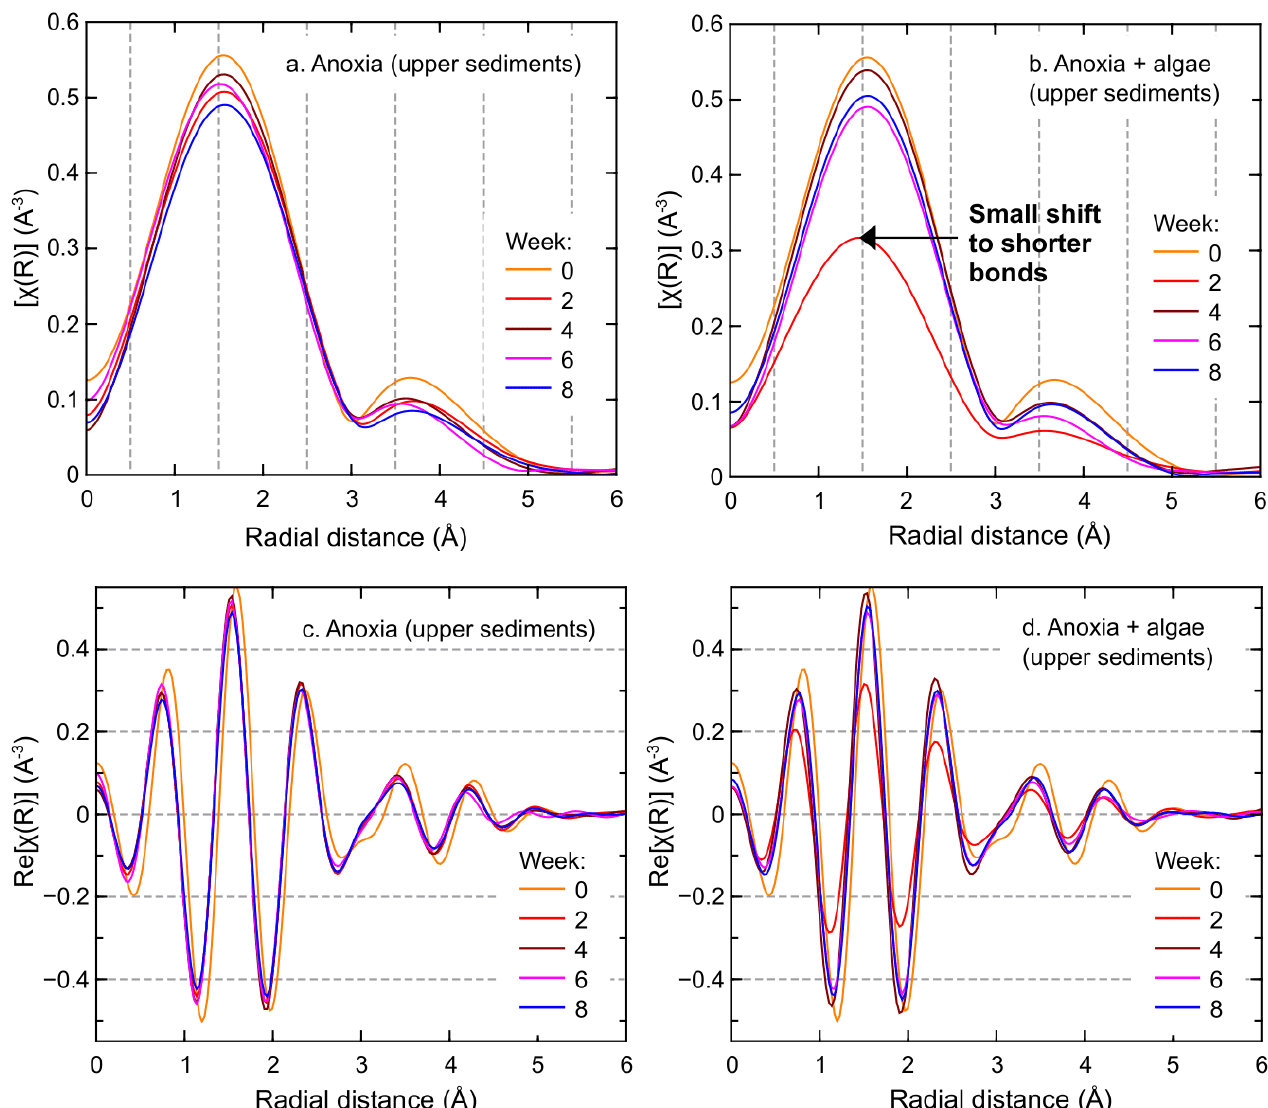
Figure 7. Fourier transformation of iron EXAFS spectra: magnitude ( χ (R)) and real portion (Re[( χ (R)])) for upper sediments of the control (anoxia) and treatment (anoxia + algae) cores over the course of the 8-week experiment.